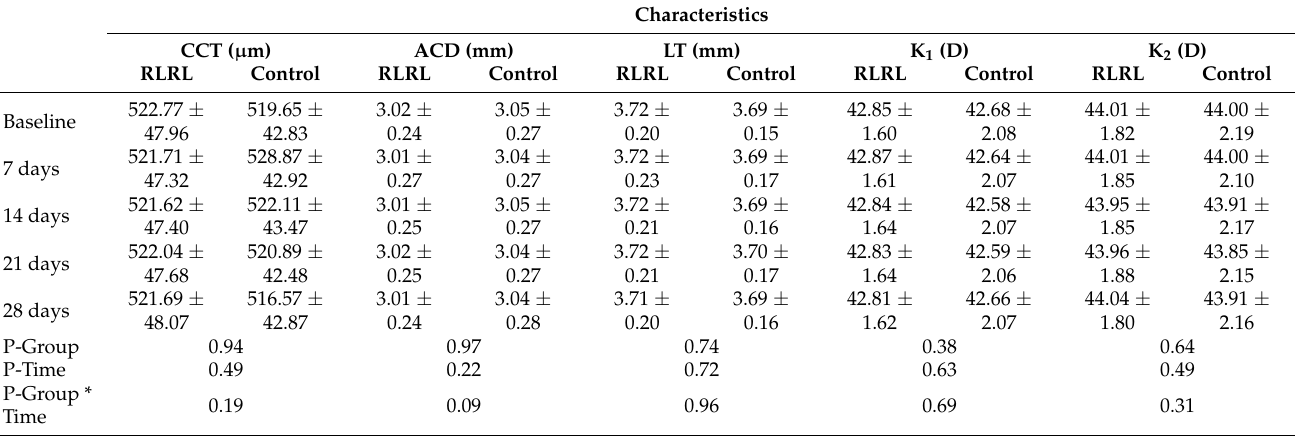
Table 3. Change in anterior segment parameters at different time points (mean ±